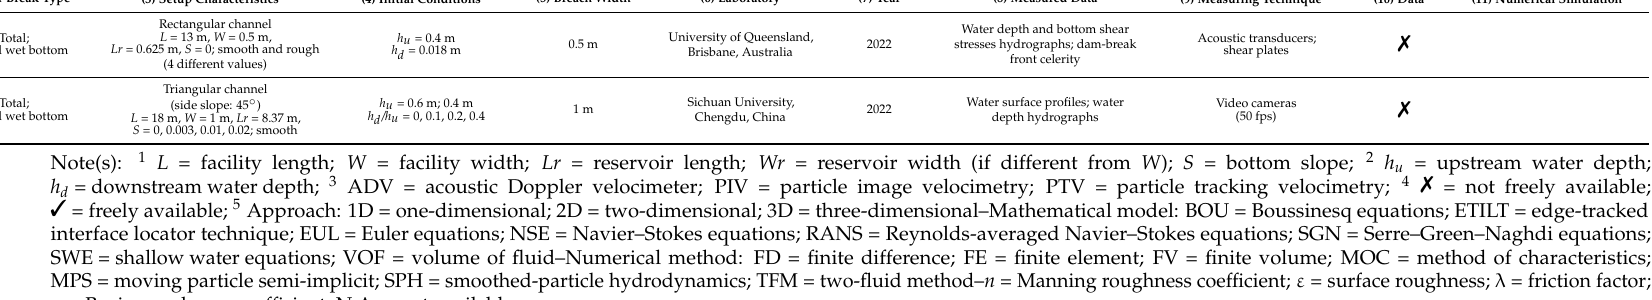
Table 1. Basic experimental investigations of fundamental dam-break wave physical characteristics.